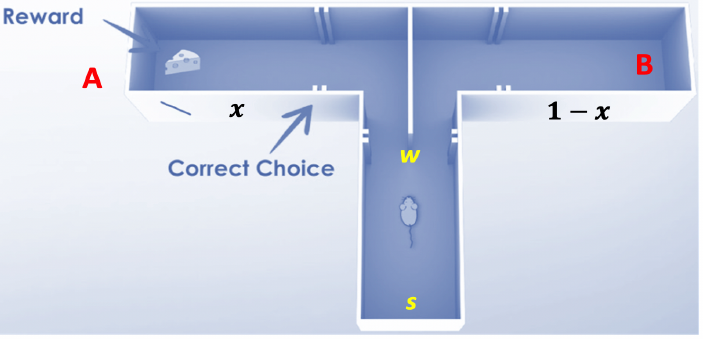
Figure 1. Behavior of a rat in a T-maze model [50].